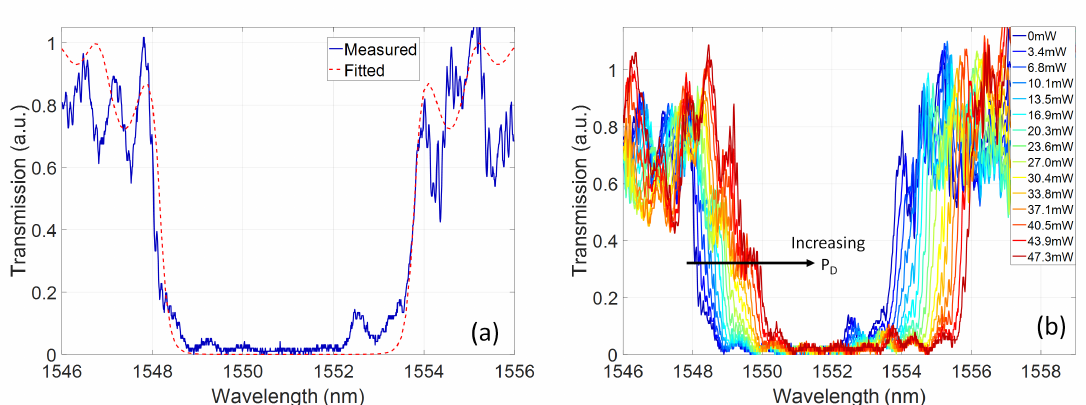
Figure 4. ( a ) Measured and fitted Bragg grating transmission spectra of the grating device in the unchirped state; and ( b ) measured grating spectra for increasing power dissipation, P D , on the thermal heating